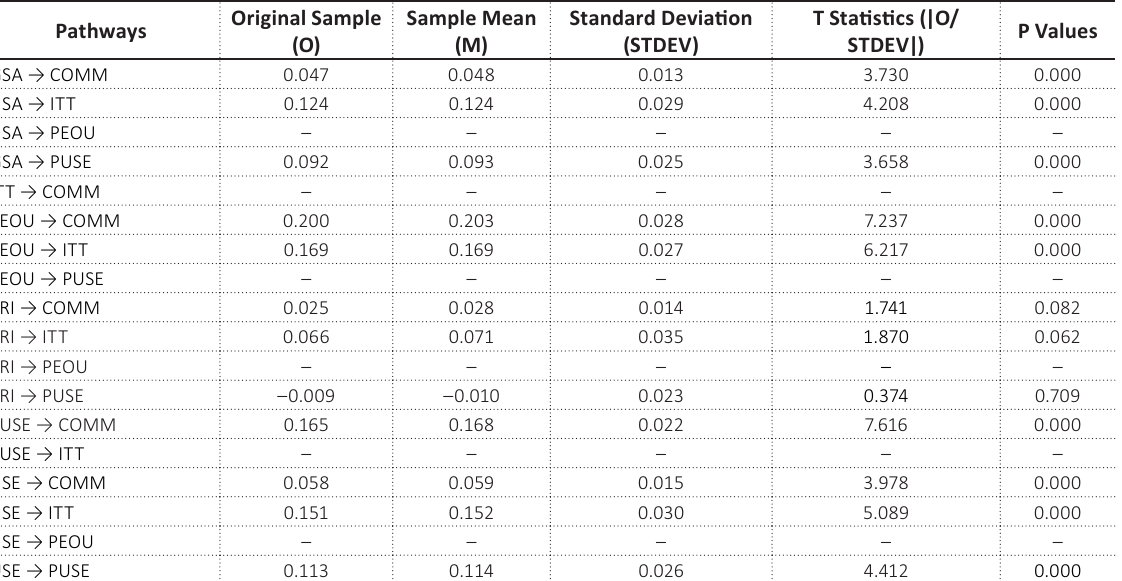
Table 8. Mediation analysis via